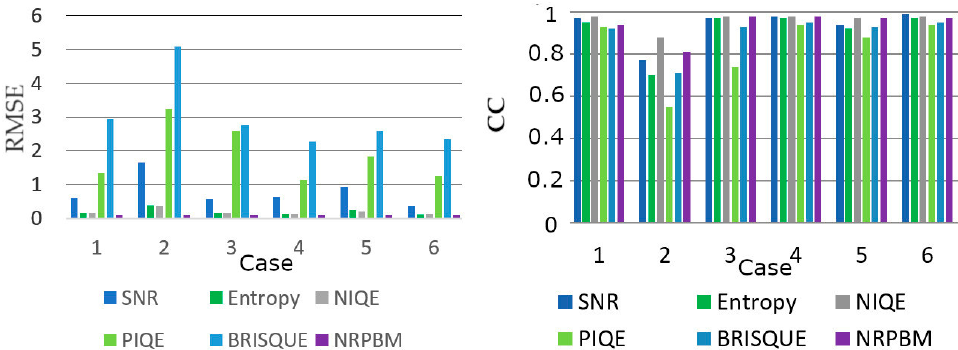
Figure 8. RMSE and CC of SNR, Entropy, NIQE, PIQE, BRISQUE and NRPBM for each of the six variants .